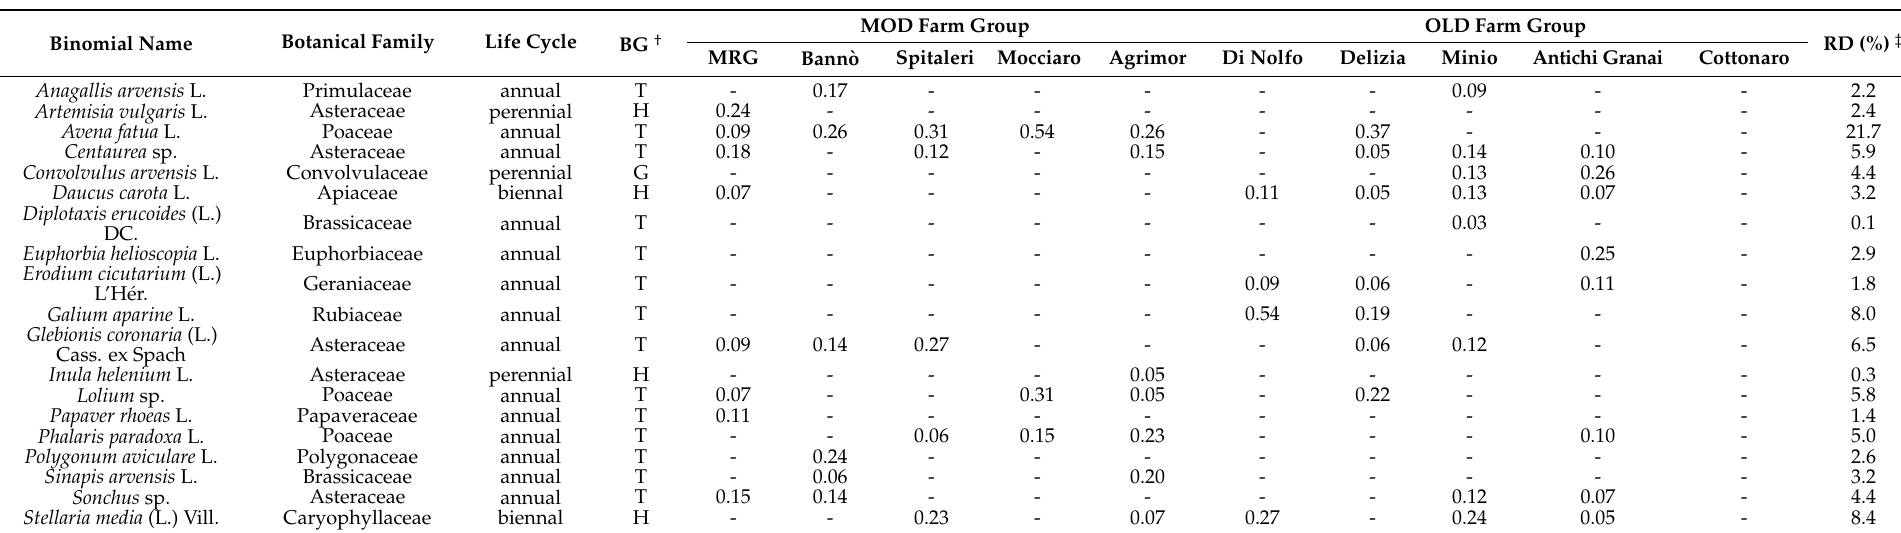
Table 3. Mean relative abundance values and mean relative densities (RD) of weed species in the real flora across the 10 farms under study. Weeds are grouped by botanical family, life cycle and biological group